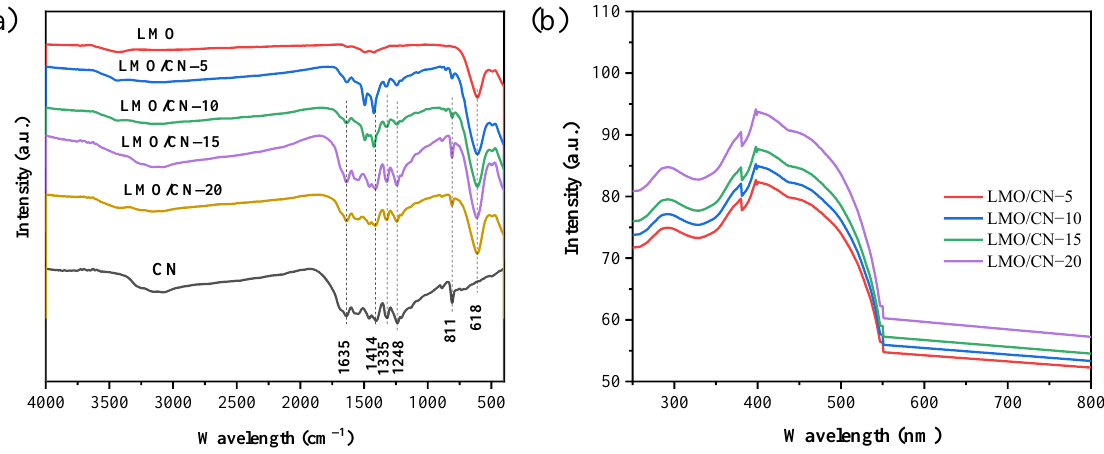
Figure 4. FT-IR spectra of CN, LMO, LMO/CN-x (x = 5, 10, 15, 20) ( a ) and UV–vis DRS spectra of LMO, LMO/CN-x (x = 5, 10, 15, 20) ( b ).